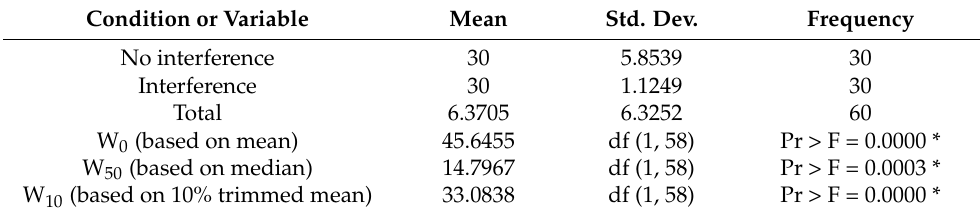
Table 5. Levene’s test of the homogeneity of variance in upload measurements.